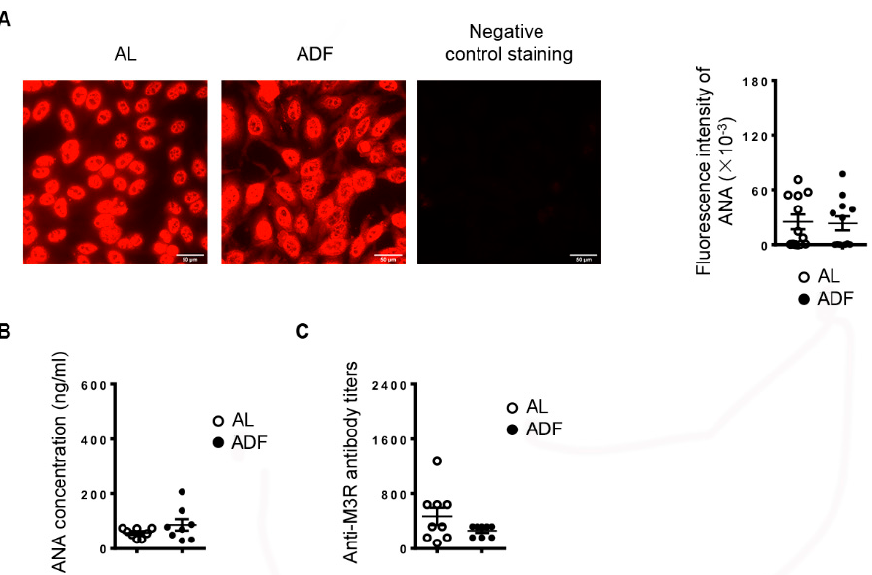
Figure 5. Alternate-day fasting (ADF) does not significantly affect autoantibody production in the serum. 10-week-old female NOD mice were deprived of food every other day or fed with standard chow ad libitum ( AL ) for 3 weeks. ( A ) Representative images of serum ANA detection (scale bar = 50 µ m). The graph shows the average fluorescence intensity of ANA staining. ( B ) ELISA analysis of serum ANA concentration. ( C ) ELISA analysis of serum anti-M3R autoantibody titers. Data are representative or the average of 9–12 mice each group.